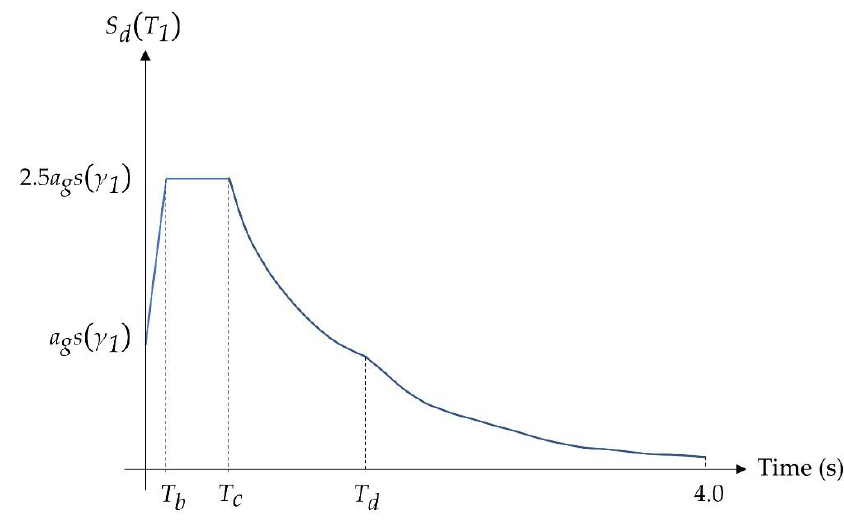
Figure 5. Elastic-design response spectrum.